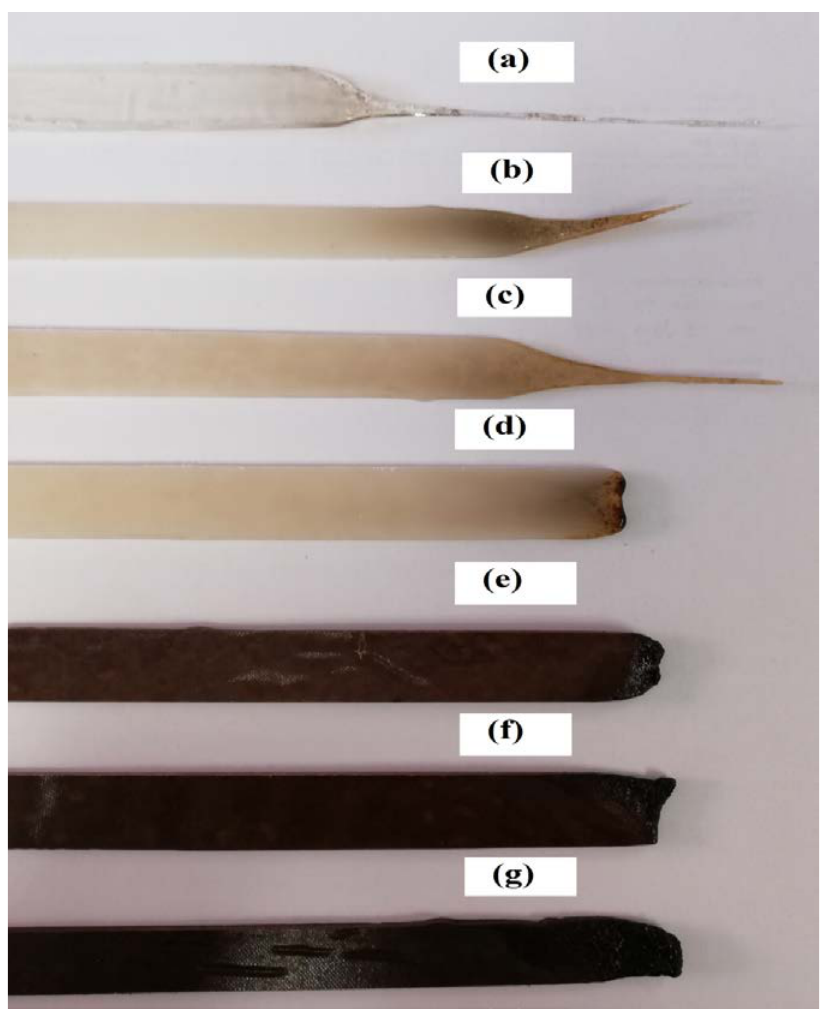
Figure 2. Photographs of pure PLA ( a ), PLA/APP10 ( b ), PLA/APP15 ( c ), PLA/APP20 ( d ), PLA/APP20/ST3 ( e ), PLA/APP20/ST5 ( f ), and PLA/APP20/ST7 ( g ) composites after UL-94 test.